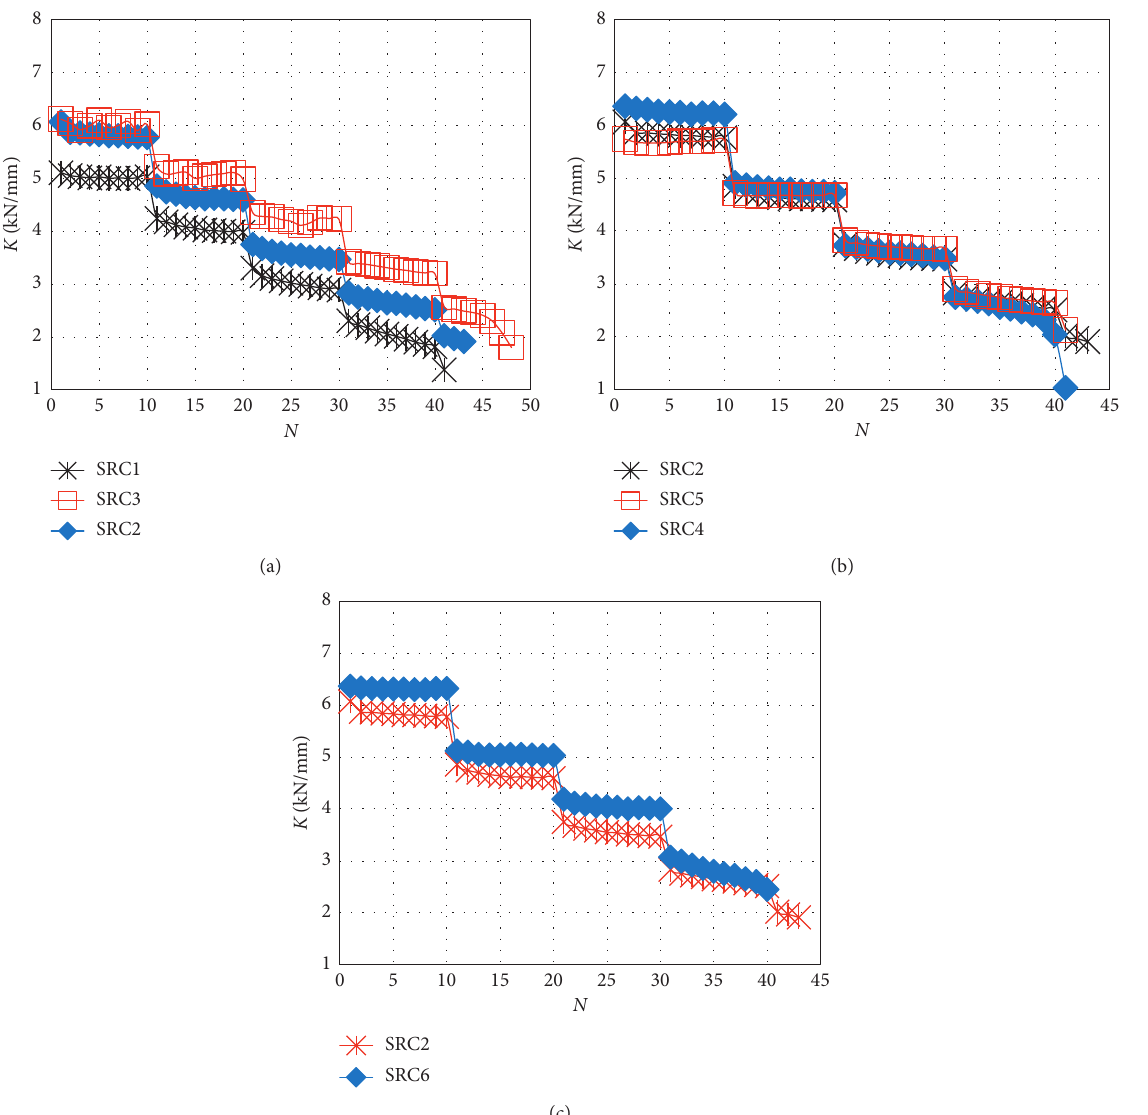
Figure 6: Secant stiffness-cycle loading number K - N curves of specimens. Effect of (a) steel ratio on K , (b) stirrup ratio on K , and (c) axial compression ratio on K